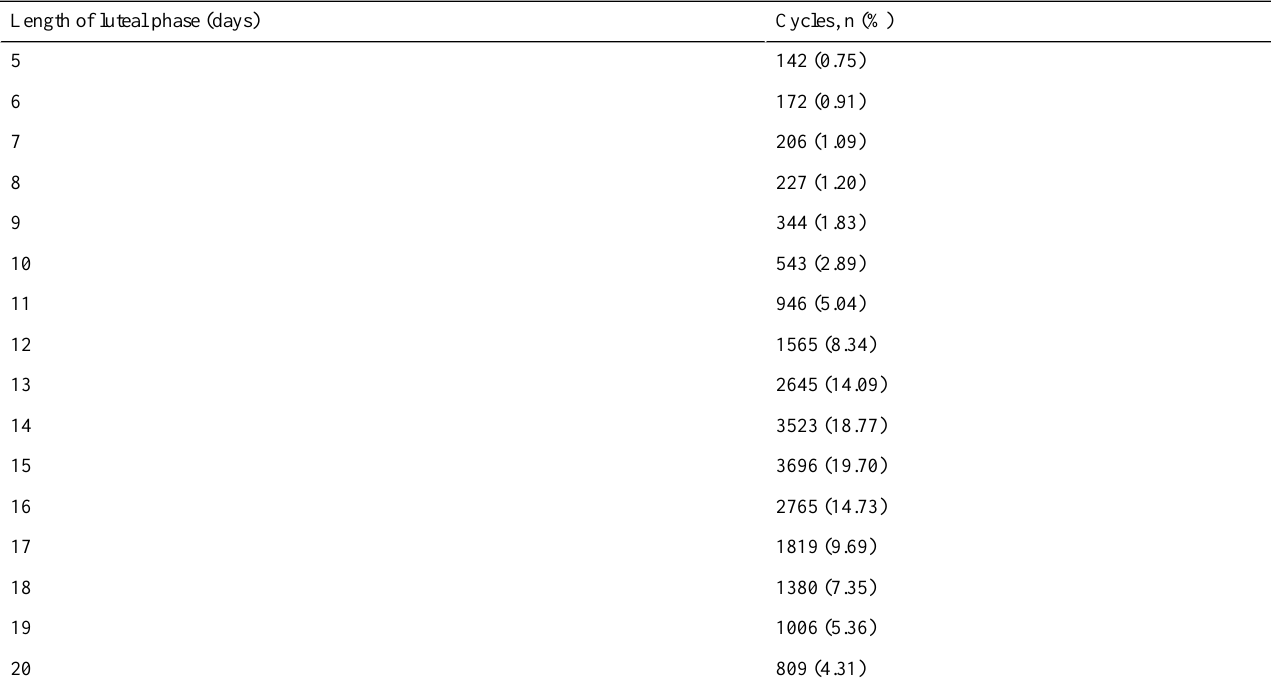
Table 4. Estimated luteal phase length based on positive luteinizing hormone test